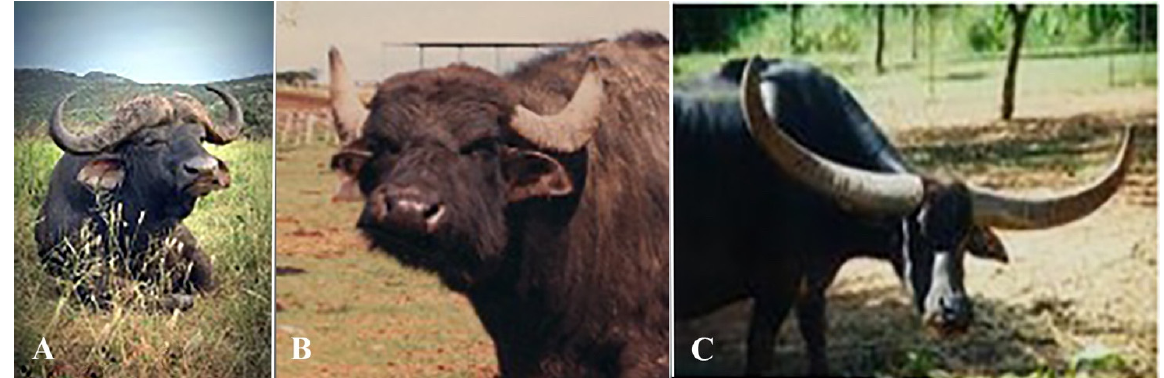
Figure 1. African ( A ) and Asian ( B , C ) buffaloes, the latter of river ( B ) and swamp ( C ) types. Standard chromosomal nomenclatures have been proposed for domestic bovids, including the river buffalo, where a standard karyotype was published using six different banding techniques [47]. This is the only example of a standard karyotype in any mam- malian species, including humans, using six different banding techniques. However, discrepancies in the standard chromosomal nomenclatures of domestic bovids were observed when comparing the G- and R-banding patterns of some chromosomes. The differences in these standard nomenclatures were observed using both chromosome banding and FISH mapping techniques, mainly using marker chromosomes (biarmed pairs) [48–50]. A final agreement for a standard chromosomal nomenclature of all of the most critical domestic bovids (including the river buffalo) was found only when the G-Q and R-banding techniques were performed on cattle chromosomes by two different cytogenetic labs also using chromosome-specific markers via FISH mapping [51,52]. The same markers used in cattle chromosomes were also assigned to river buffalo, sheep, and goat chromosomes via FISH mapping [53,54], further supporting the agreement of the results obtained at the ISCNDB2000